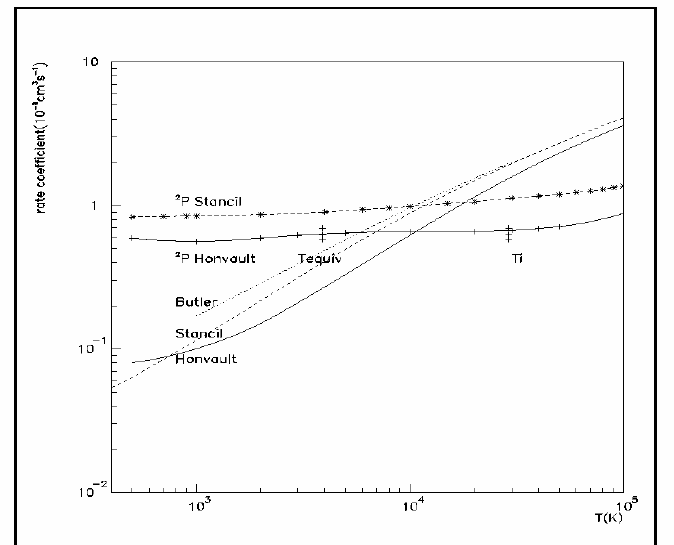
Fig. 6 : Rate coefficients as a function of temperature for Si 3+ + He. Comparison of close coupling calculations, Honvault et al. [1] (full curves) ; Stancil et al. [2] (broken curves) and Landau-Zener approach, Butler et al. [24] (dotted curve) with ion trap experiment at T